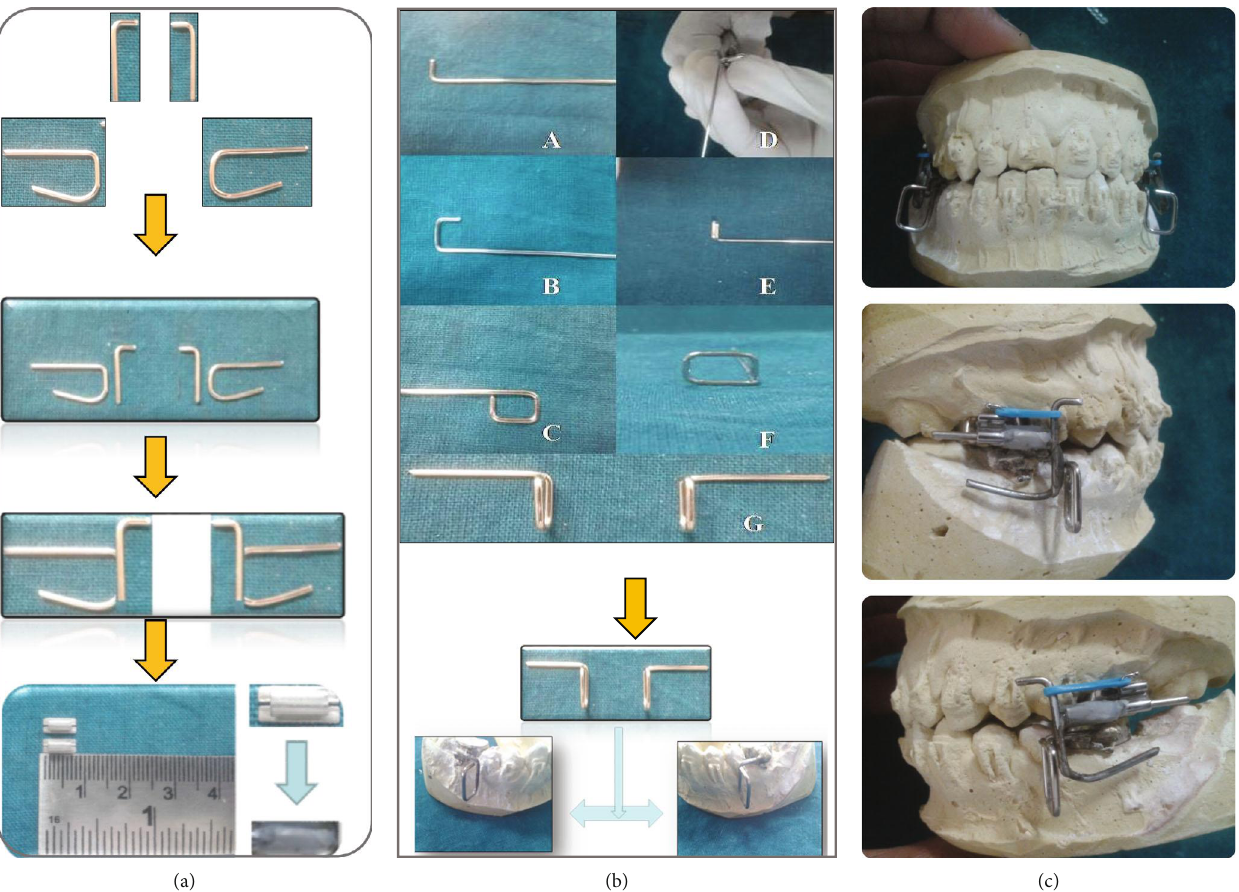
Figure 2: Schematic representation of steps in fabrication of appliances: (a) upper assembly, (b) lower assembly, and (c) in-house